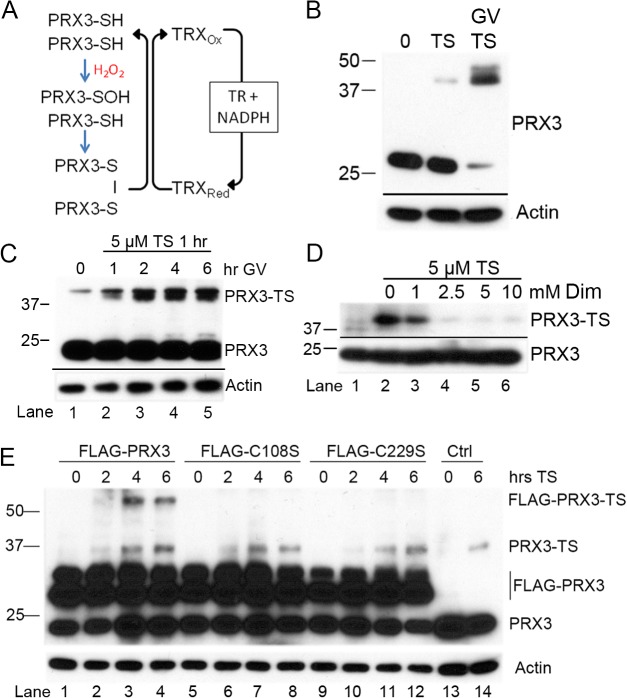
PRX3 turnover promotes adduction of specific cysteine residues by thiostrepton in cells.(A) Reconstitution of the PRX3 catalytic cycle in vitro with purified components. (B) MM cells were treated with 5 μM TS for 18 hr or pre-incubated with 1 μM GV for 6 hr then treated with 5 μM TS (G/T) for 18 hr and immunoblotted for PRX3 after reducing SDS-PAGE. (C) MM cells were pre-incubated with 1 μM GV for the indicated times and then treated with 5 μM TS for 1 hr and cell lysates were immunoblotted for PRX3 after reducing SDS-PAGE. (D) Pre-incubation of MM cells with dimedone (Dim) for 6 hr blocked TS induced modification of PRX3. (E) HM Cells transfected with Flag-Tagged PRX3 expression plasmids were treated with 5 μM TS, lysates were collected at the indicated time points and TS induced modifications of PRX3 were visualized by immunoblotting with anti-PRX3 antibody after separation by reducing SDS-PAGE. See also S1 Fig.